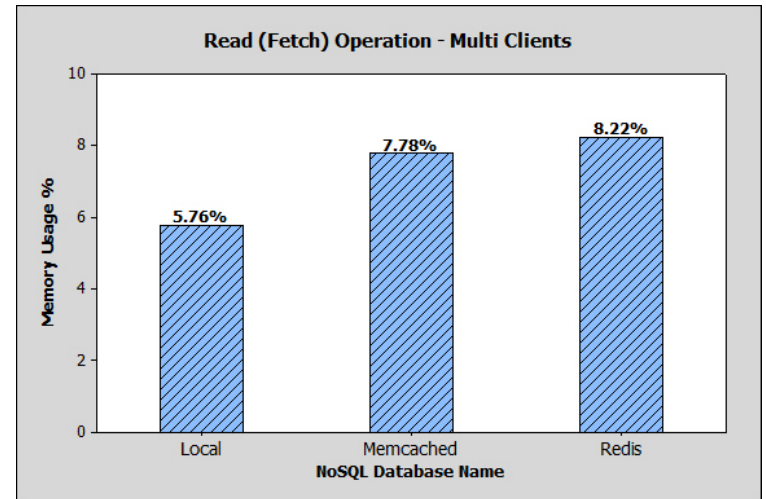
Figure 8. Memory usage with read operation (multi clients).